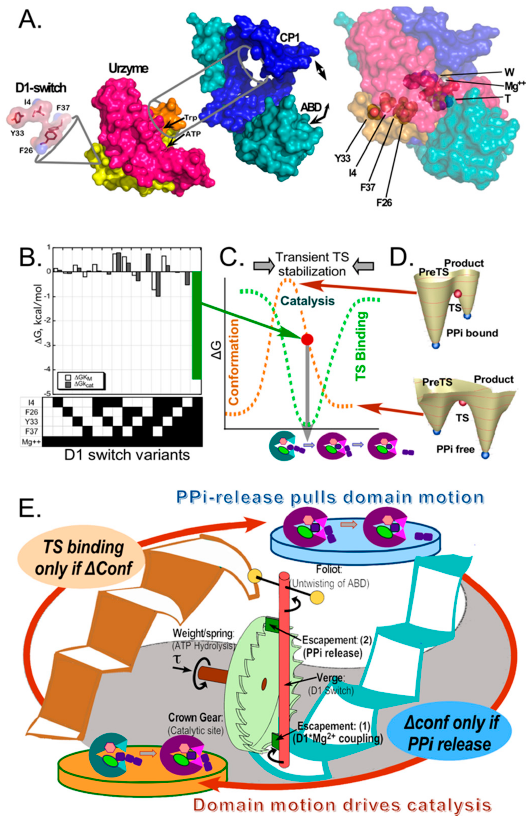
Figure 2. Reciprocally-coupled gating in the TrpRS escapement mechanism. ( A ). Structural biology of the TrpRS monomer. The catalytic machinery is located within the Urzyme and is modified by its interaction with two accessory domains, including the CP1 (Connecting Peptide 1 [67,68]; blue) and the anticodon-binding domain (ABD; teal), which move relative to the active-site. The D1 switch is located within the Protozyme (yellow), which is the first crossover connection of the Rossmann fold within the Urzyme. The specificity helix (sand) connects the first and second halves of the Urzyme (yellow, red). The D1 switch is~20 Å from the active-site metal ion. (adapted from [2].) ( B ). Combinatorial mutagenesis of the TrpRS D1 switch revealed that the entire catalytic contribution of the catalytic Mg 2+ ion (~5 Kcal/mole) can be attributed to the 5-way interaction between it and the four D1 residues. ( C ). B–D were adapted, with permission, from [6]. Multiple studies [69–72] showed that the PreTS state TrpRS conformation is an excited state~3 kcal/mole higher in energy than either the open or Products ground states (brown dashed curve). Data from ( A ) show that the conformation complementary to the transition state for amino acid activation develops transiently, during domain motion from the PreTS to the Products conformation (green dashed curve). ( D ). Computational free energy surfaces of the transition between PreTS and Products states [4] with and without the product PPi show that the conformational equilibrium shifts to favor the Products conformation if and only if the PPi is absent from the active site. ( E ). Schematic representation of the reciprocally coupled gating as a strange loop, emphasizing the parallel between the data in ( B – D ) and the two green blades (Escapement (1) and (2)) that make the rotation of the crown gear in the escapement mechanism of a mechanical clock conditional on the rotation cycle of the pendulum or